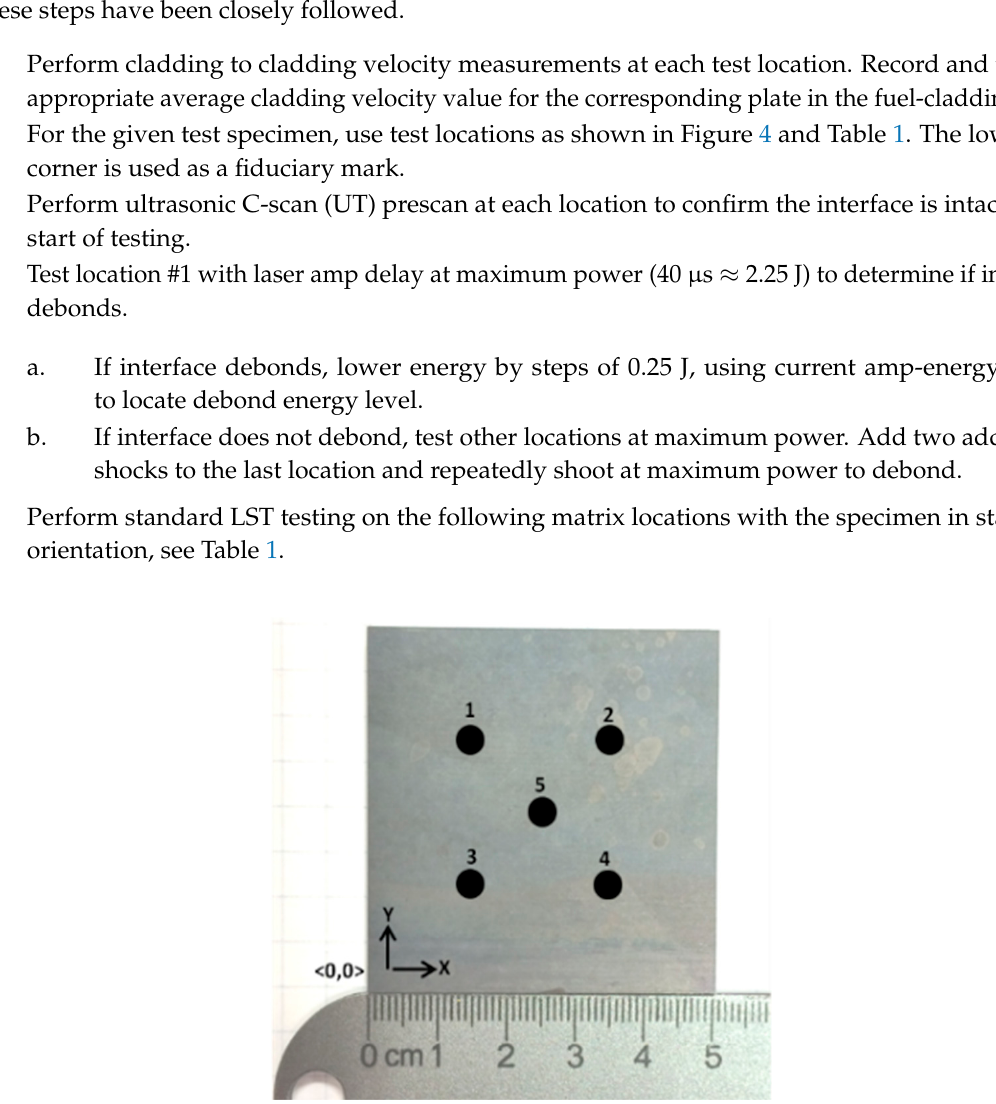
Figure 4. Example of clad-clad plate with locations for shock testing indicated. Table 1. Example of clad–clad shock locations. Al-Al Cladding Shot Points